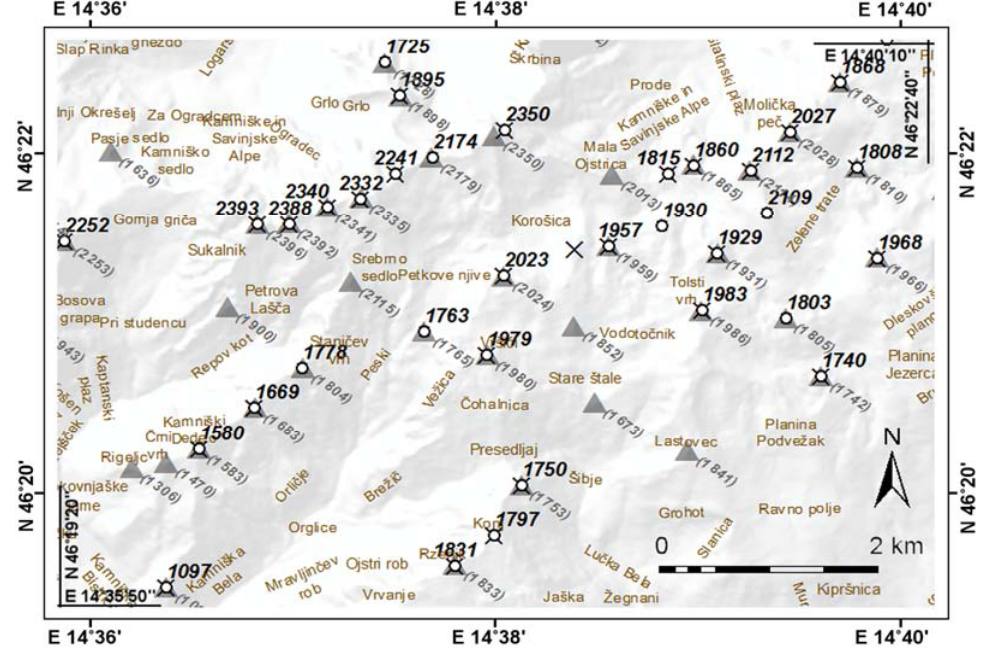
Figure 9. Assessment of the peaks generated by the automated method (dots with altitude) (List 0), compared to those peaks from DTK 25 (triangles with altitude in brackets) and also compared to Wood’s method [29] (crosses) (List W), and labeled with geographical names from REZI 25. A zoom-in area (see Figure 7) with dimensions of 8 km × 6 km is presented.